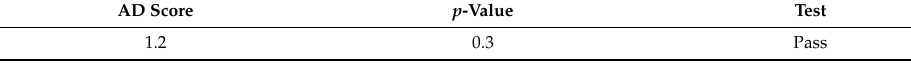
Table 13. AD test normal period, ST, tail of data.